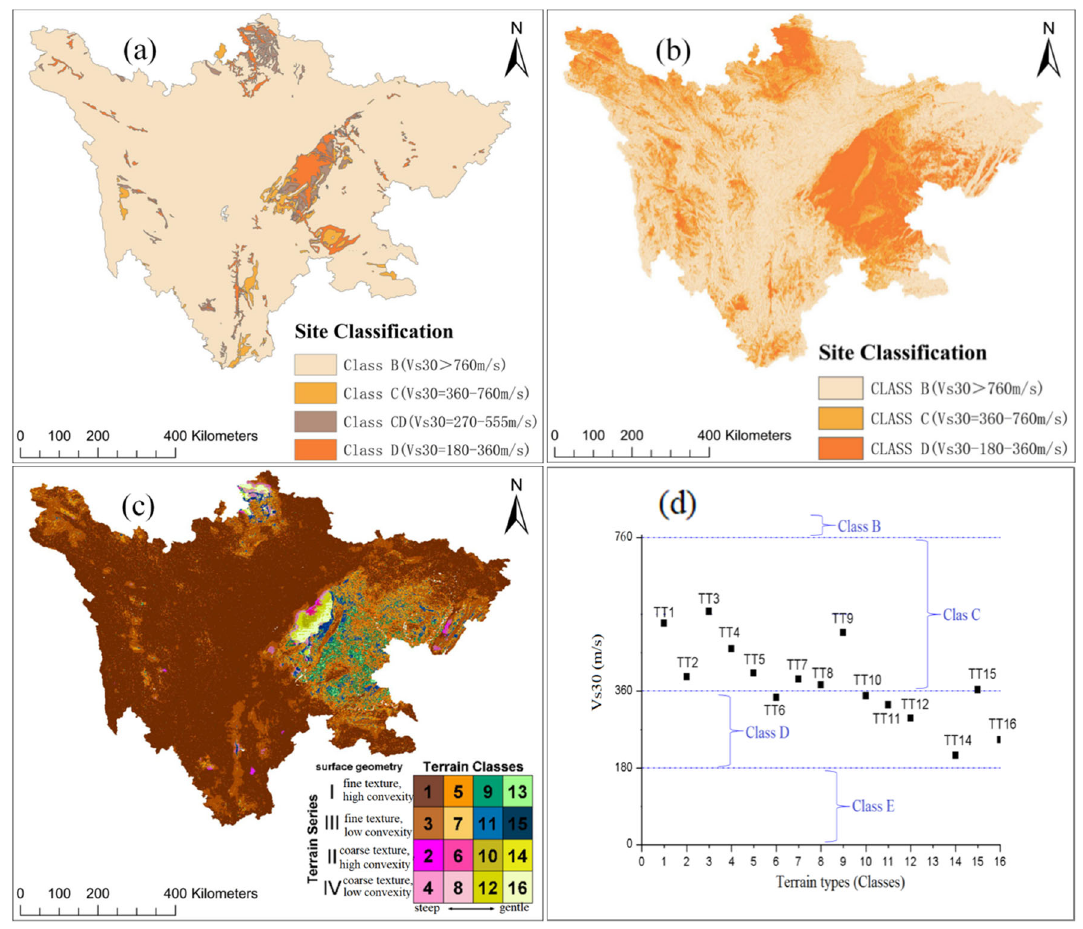
Fig. 2 Site classification of Sichuan Province by: a the geology- based approach; b the topographic slope-based approach; and c the terrain-based approach. The ranges of V s30 values of specific site